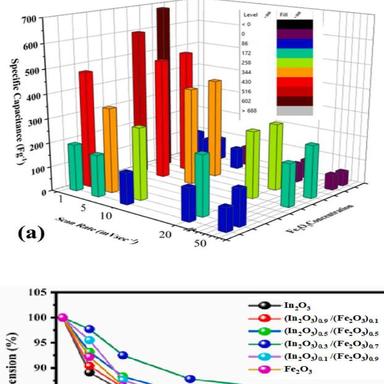
(a) Specific capacitance (Fg− 1 ) (b) Retention (%) in specific capacitance of all samples concerning capacitance of that sample at 1 mV s -1 vs applied scan rates (mVsec− 1 ).